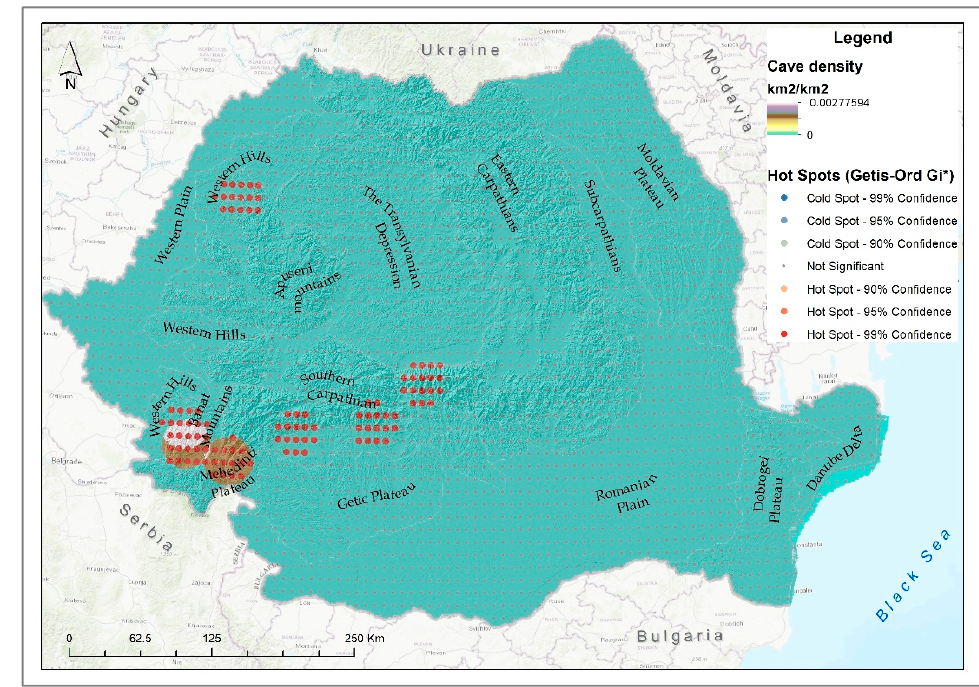
Figure 6. Cave degraded ecosystem density and hotspot analysis.